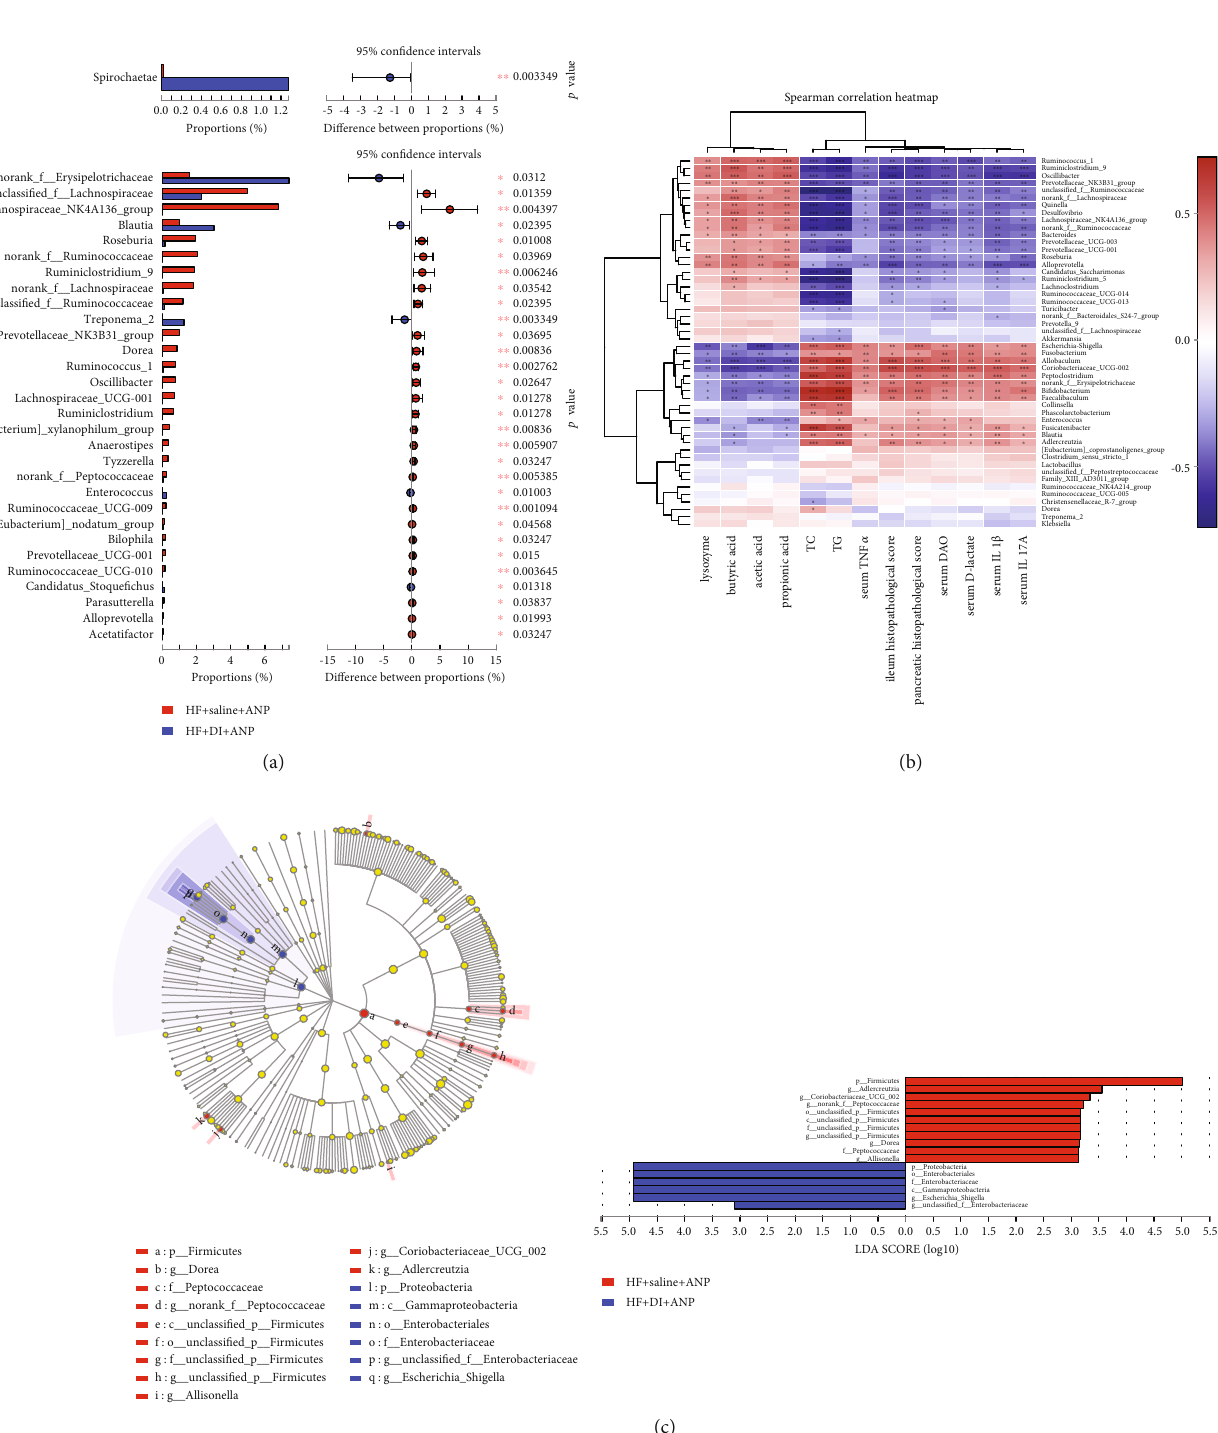
Figure 9: E ff ects of dithizone on microbiota composition in rats on high-fat diet followed by retrograde sodium taurocholate infusion. (a) Bacterial phyla and genera with signi fi cantly di ff erent abundance in rats treated with dithizone or saline. ∗ p < 0 : 05 , ∗∗ p < 0 : 01 , ∗∗∗ p < 0 : 001 , Wilcoxon test. (b) Heatmap showing correlation among SCFAs, lysozyme, intestinal barrier dysfunction, serum lipid, pathological changes, and gut micro fl ora. Blue indicates a negative correlation, while red indicates a positive correlation. ∗ p < 0 : 05 , ∗∗ p < 0 : 01 , ∗∗∗ p < 0 : 001 . Spearman test. (c) LEfSe multilevel species hierarchy tree and LEfSe bars discriminated by LDA. n = 8 for each